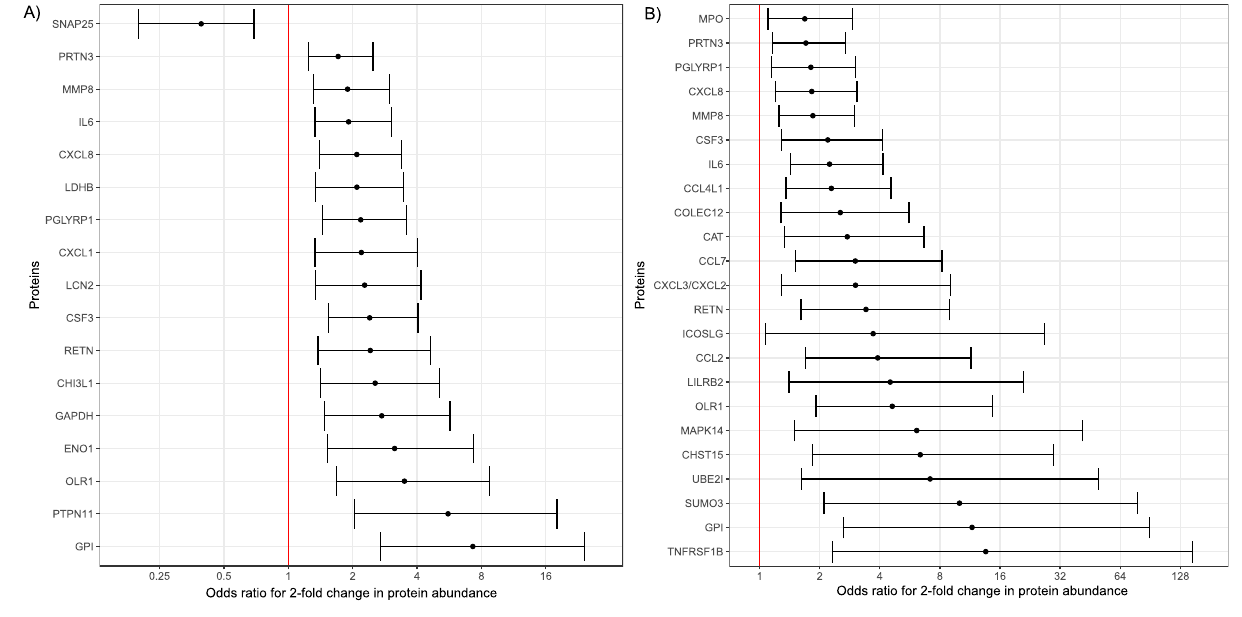
Figure 1. Odds ratio (and 95% confidence intervals) for the association between amniotic fluid proteins and imminent delivery. ( A ) Odds ratios for delivery within two weeks and ( B ) within one week. Odds ratios are adjusted for quantitative cervical length. The odd-ratios are calculated for a two-fold change in protein abundance. Alpha-enolase (ENO1), C–C motif chemokine 2 (CCL2), C–C motif chemokine 4-like (CCL4L1), C–C motif chemokine 7 (CCL7), C-X-C motif ligand 8 (CXCL8), Carbohydrate sulfotransferase 15 (CHST15), Catalase (CAT), Chitinase-3-like protein 1 (CHI3L1), Collectin-12 (COLEC12), Glucose-6-phosphate isomerase (GPI), Glyceraldehyde-3-phosphate dehydrogenase (GAPDH), Granulocyte colony-stimulating factor (CSF3), Gro-beta/gamma (CXCL3/CXCL2), Growth-regulated alpha protein (CXCL1), ICOS ligand (ICOSLG), Interleukin-6 (IL6), L-lactate dehydrogenase B chain (LDHB), Leukocyte immunoglobulin-like receptor subfamily B member 2 (LILRB2), Matrix Metalloproteinase-8 (MMP8), Mitogen-activated protein kinase 14 (MAPK14), Myeloperoxidase (MPO), Neutrophil gelatinase-associated lipocalin (LCN2), Oxidized low-density lipoprotein receptor 1 (OLR1), Proteinase 3 (PRTN3), Peptidoglycan recognition protein 1 (PGLYRP1), Resistin (RETN), Small ubiquitin-related modifier 3 (SUMO3), SUMO-conjugating enzyme UBC9 (UBE2I), Synaptosomal-associated protein 25 (SNAP25), Tumor necrosis factor receptor superfamily